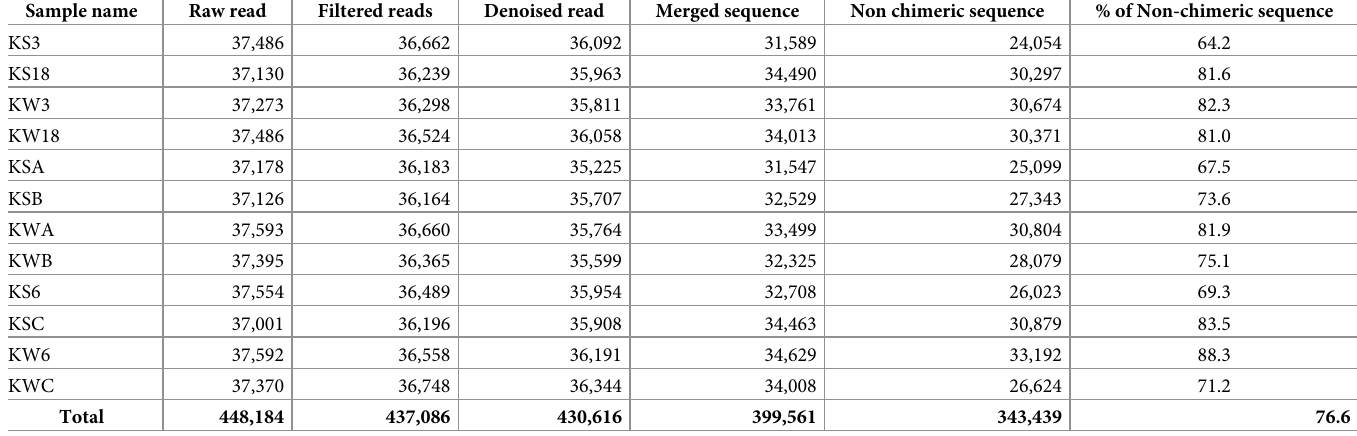
Table 2. Summary of raw and filtered